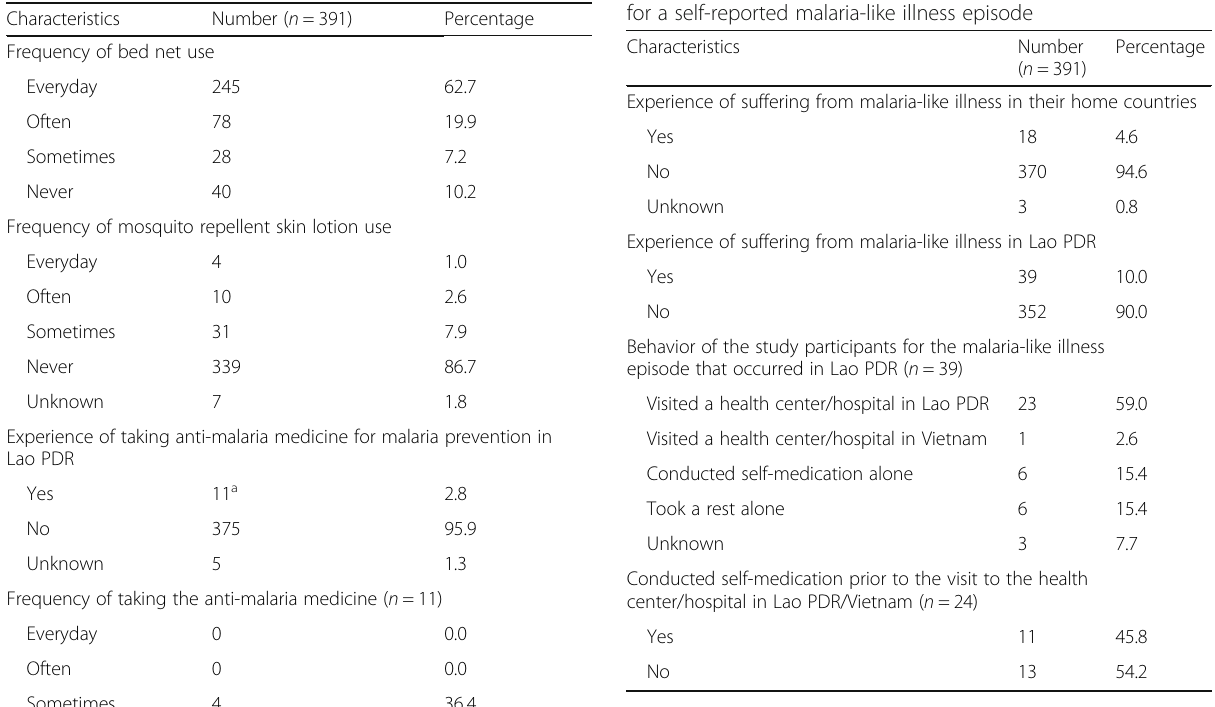
Table 4 Treatment-seeking behavior of the study